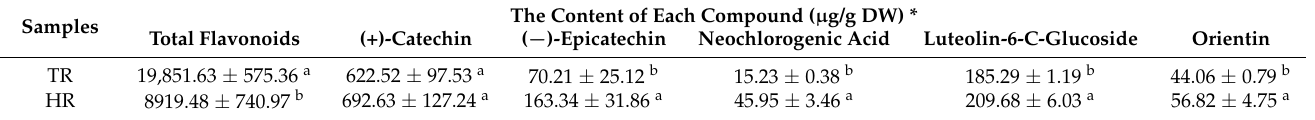
Table 6. Flavonoids contents of hairy roots and true roots.